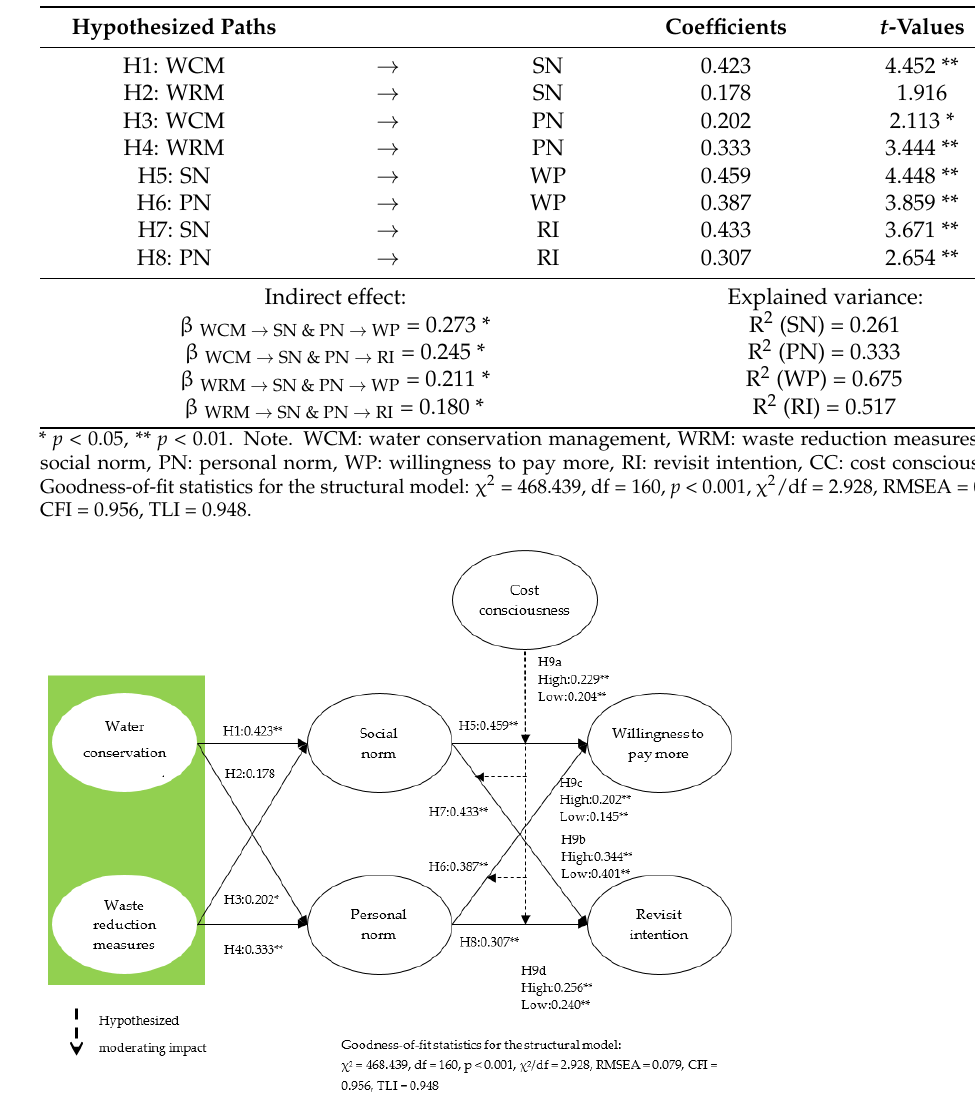
Table 2. Structure model results.